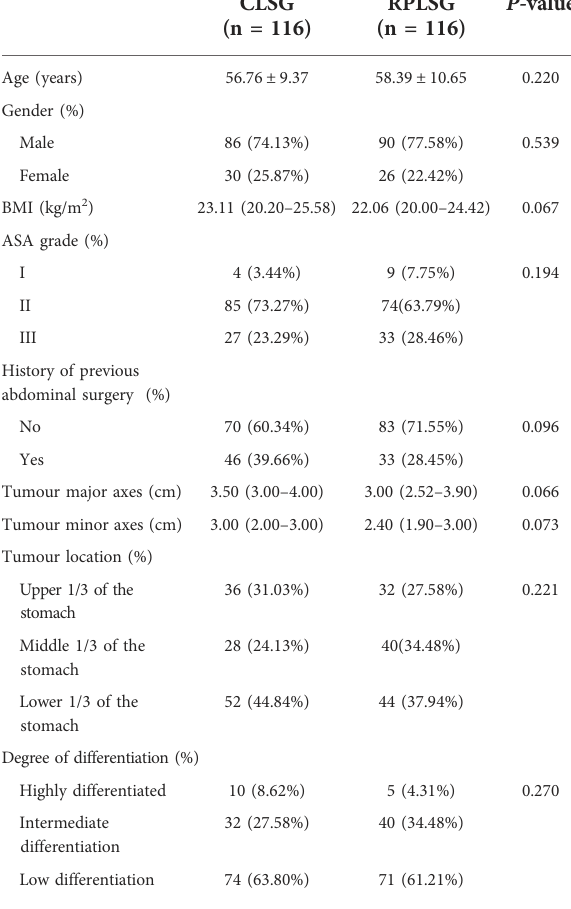
TABLE 2 Intraoperative correlation